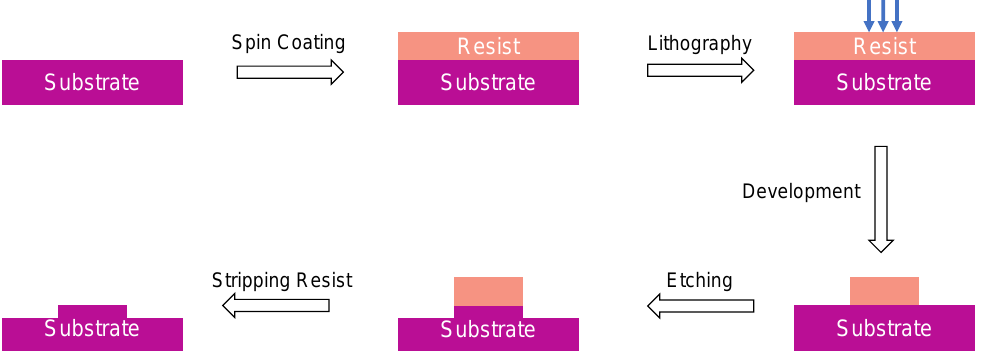
Figure 2. Steps of the top-down (Al)GaAs waveguide fabrication